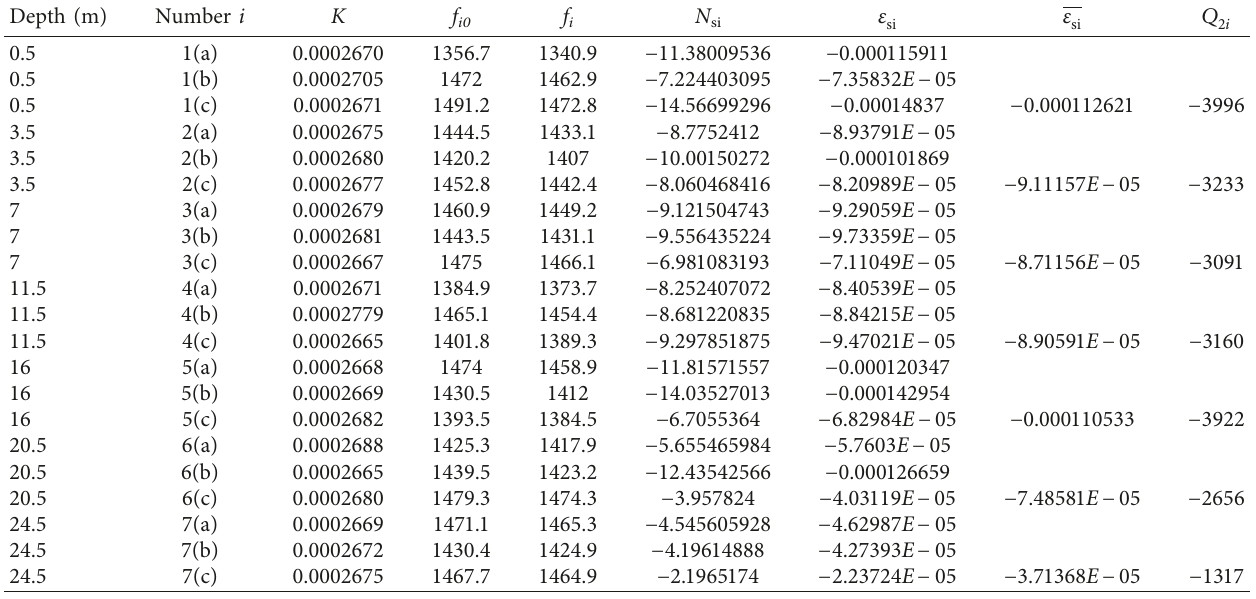
Table 3: Axial force calculation table of the pile TS2 body under